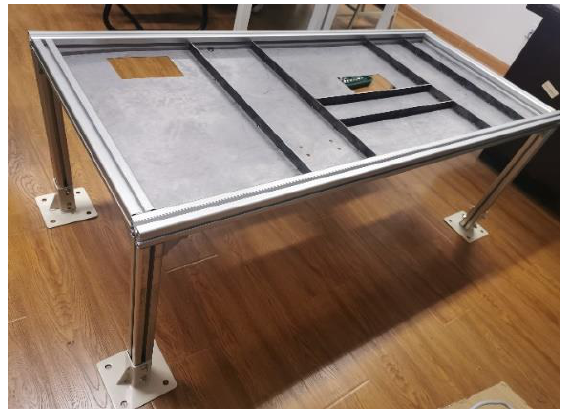
Figure 6. Test Figure 6. Test bench.